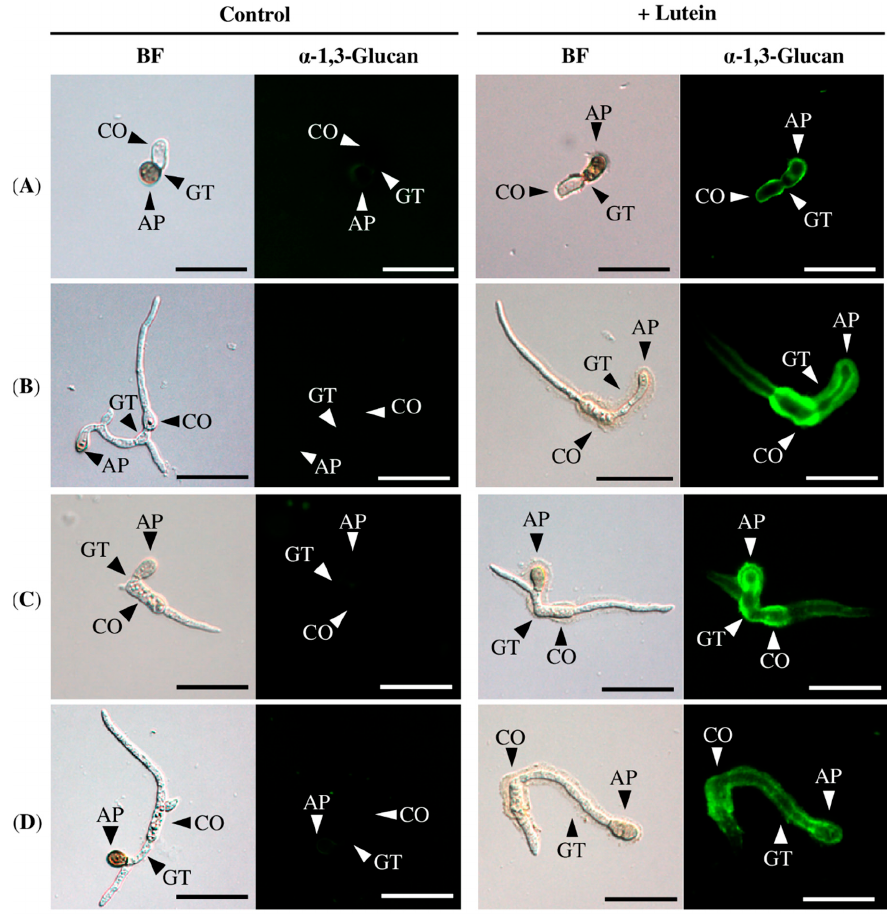
Figure 4. Surface accumulation of α -1,3-glucan on the cell walls of Colletotrichum species in the